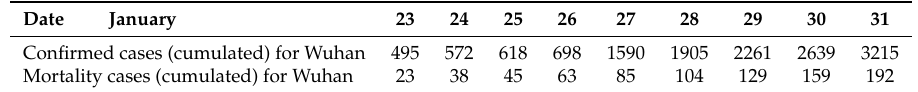
Table 4. Reported case data 23–31 January 2020, reported for Wuhan Municipality by the Wuhan Municipal Health Commission